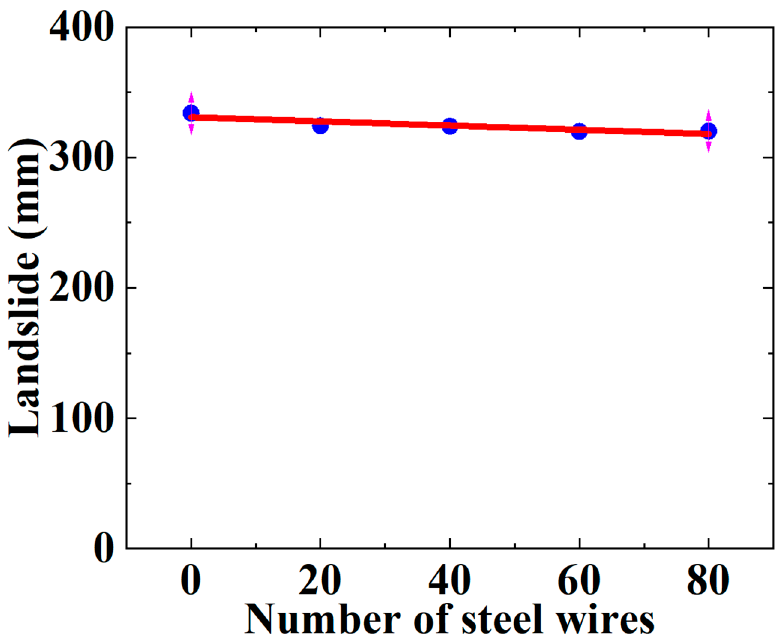
Figure 25. Influence of steel-wire number on the maximum landslide of SWW-RTP.